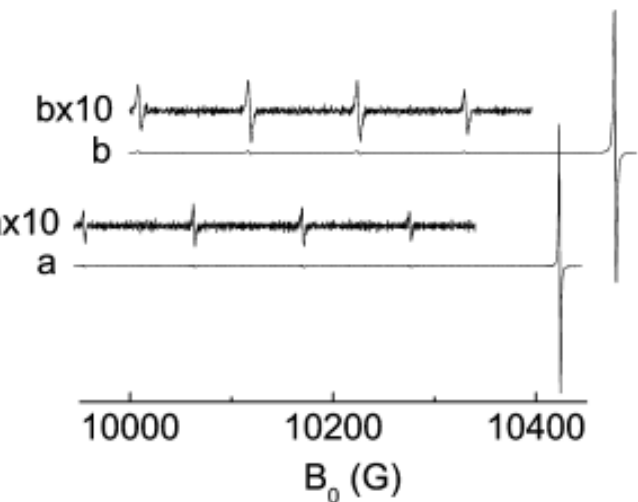
Figure 1. The ESR spectra in the sealed cell containing 3 O 2 (P O2 = 0.2 Torr) and a sensitized naphthalene vapor obtained in the dark ( a ) and during irradiation of a sensitizer ( b ), T = 293 K. The intensity component in the high field ( a , b ) is part of the ESR of 3 O 2 ( 3 Σ g − ). The ESR spectrum of 1 O 2 ( 1 ∆ g) consisting of four components (b and b × 10, a and a × 10) was obtained under photoexcitation of naphthalene in the presence of 3 O 2 . Adapted from ref. [9].